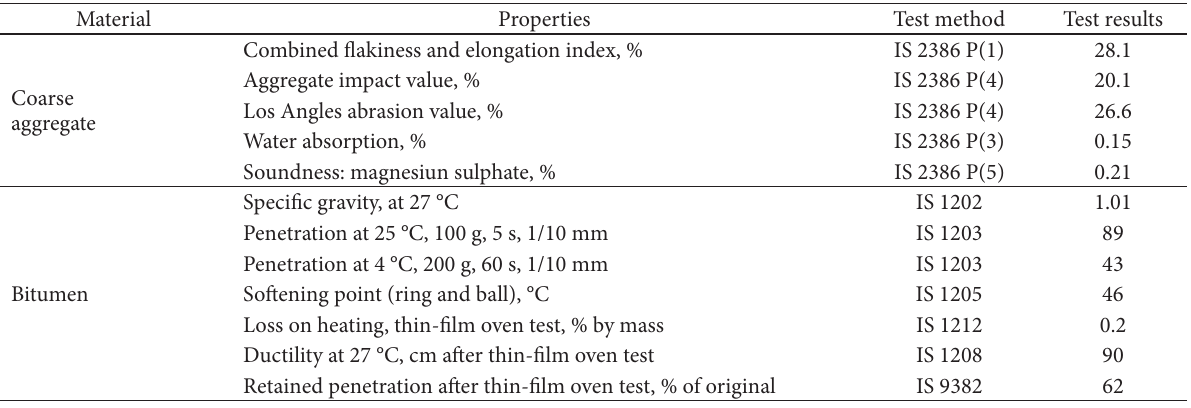
Table 1. Properties of coarse aggregate and bitumen